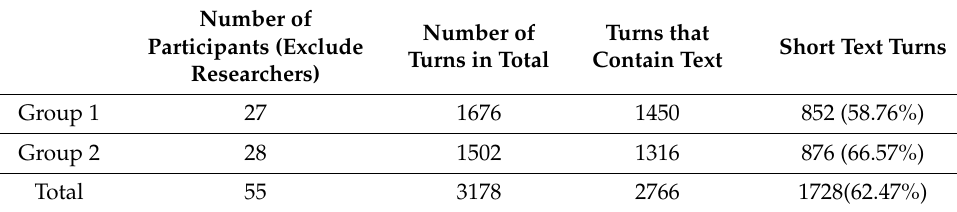
Table 2. Size of data and features of